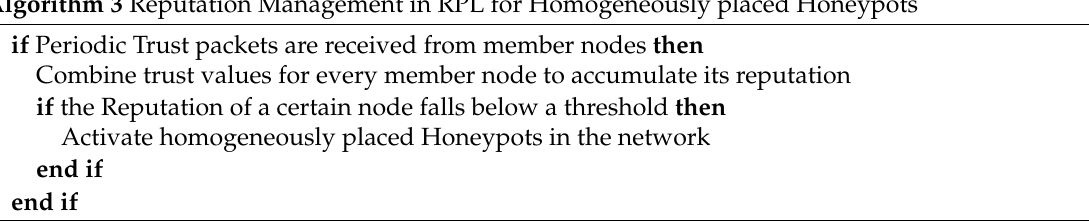
Algorithm 3 Reputation Management in RPL for Homogeneously placed